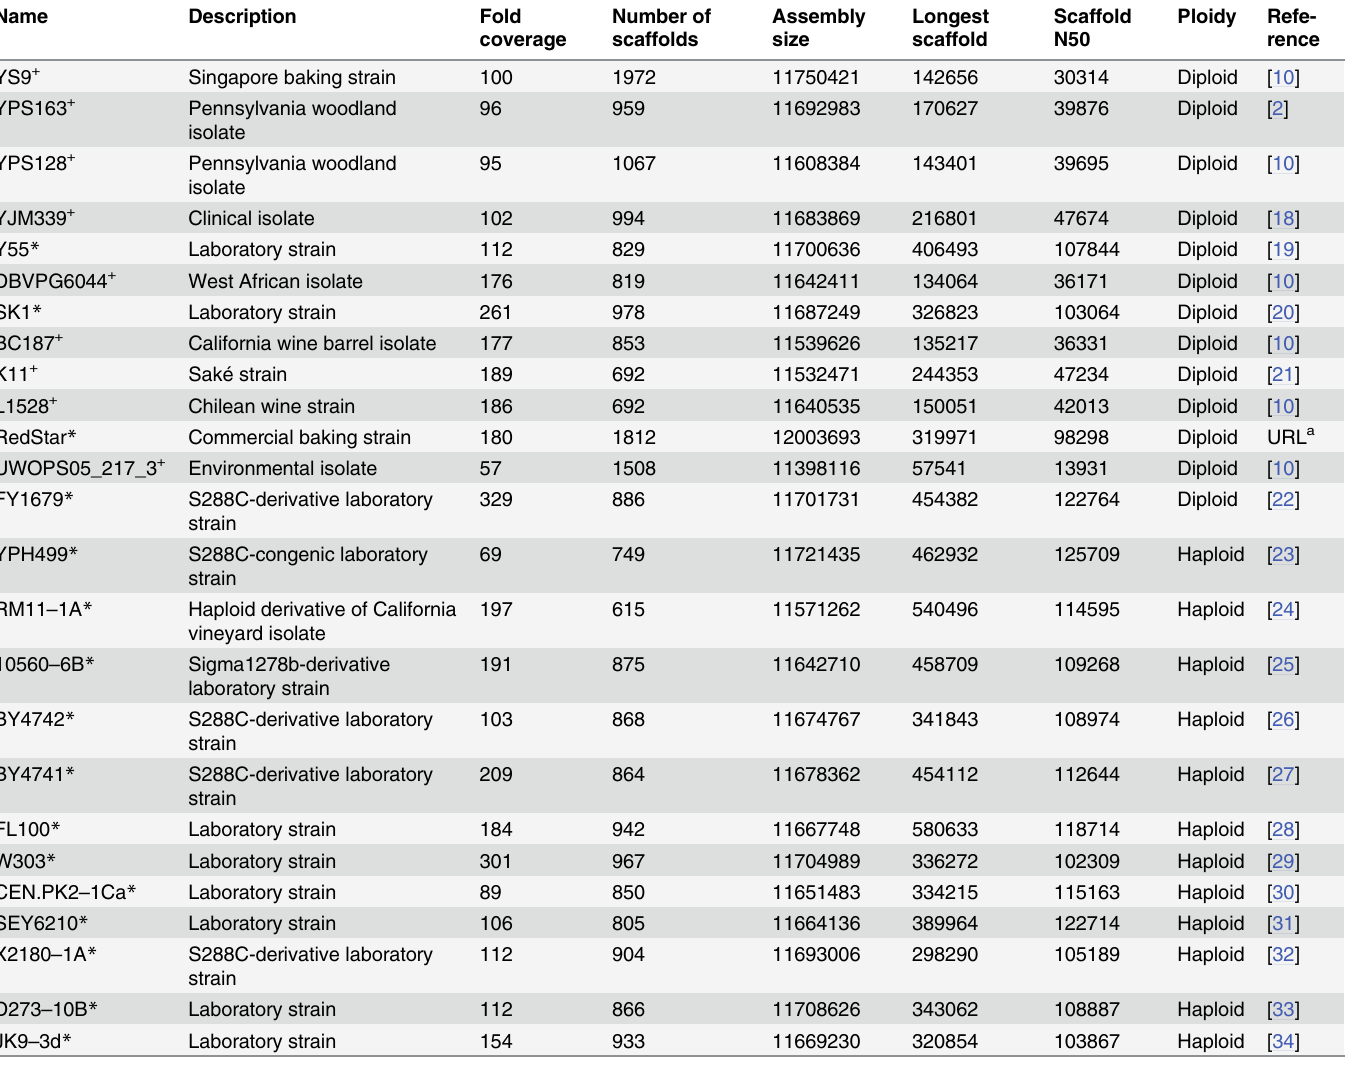
Table 2. Short description and assembly statistics of the 25 S . cerevisiae strains explored in this